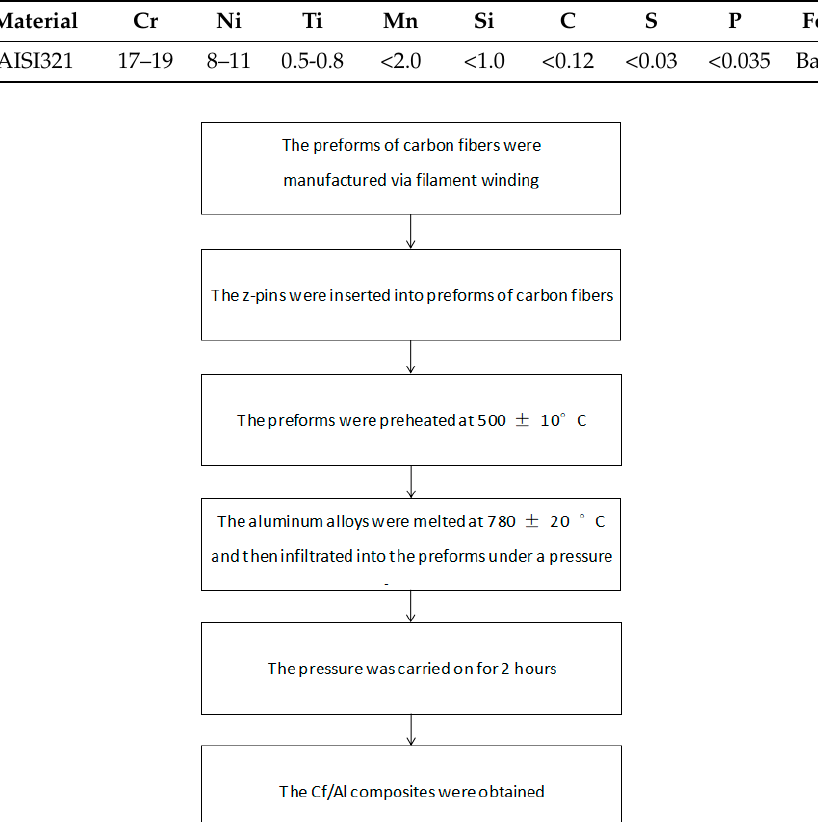
Table 3. Chemical composition of AISI321 (wt %).